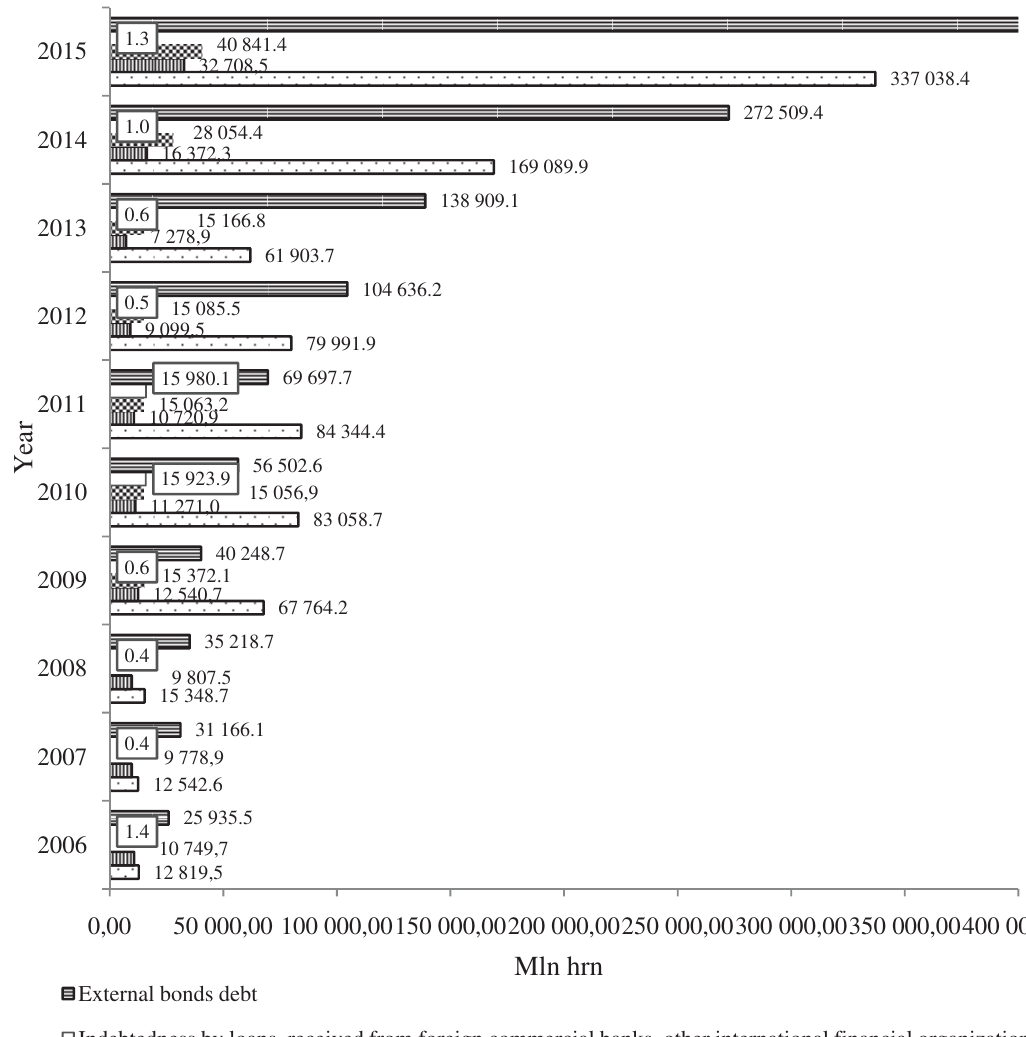
Fig. 6. The dynamics of change of external debt structure during 2006-2015, mln